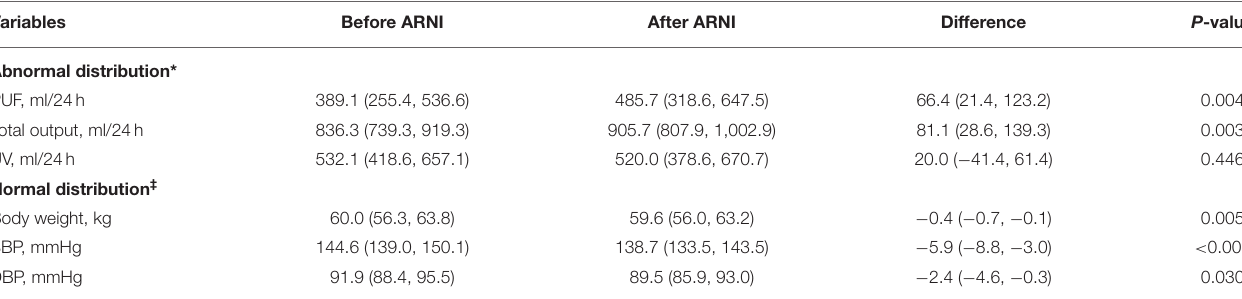
TABLE 2 | Comparison of the PUF, Total output, UV, Body weight and BP in PD patients before and after ARNI initiating. Variables Before ARNI After ARNI P